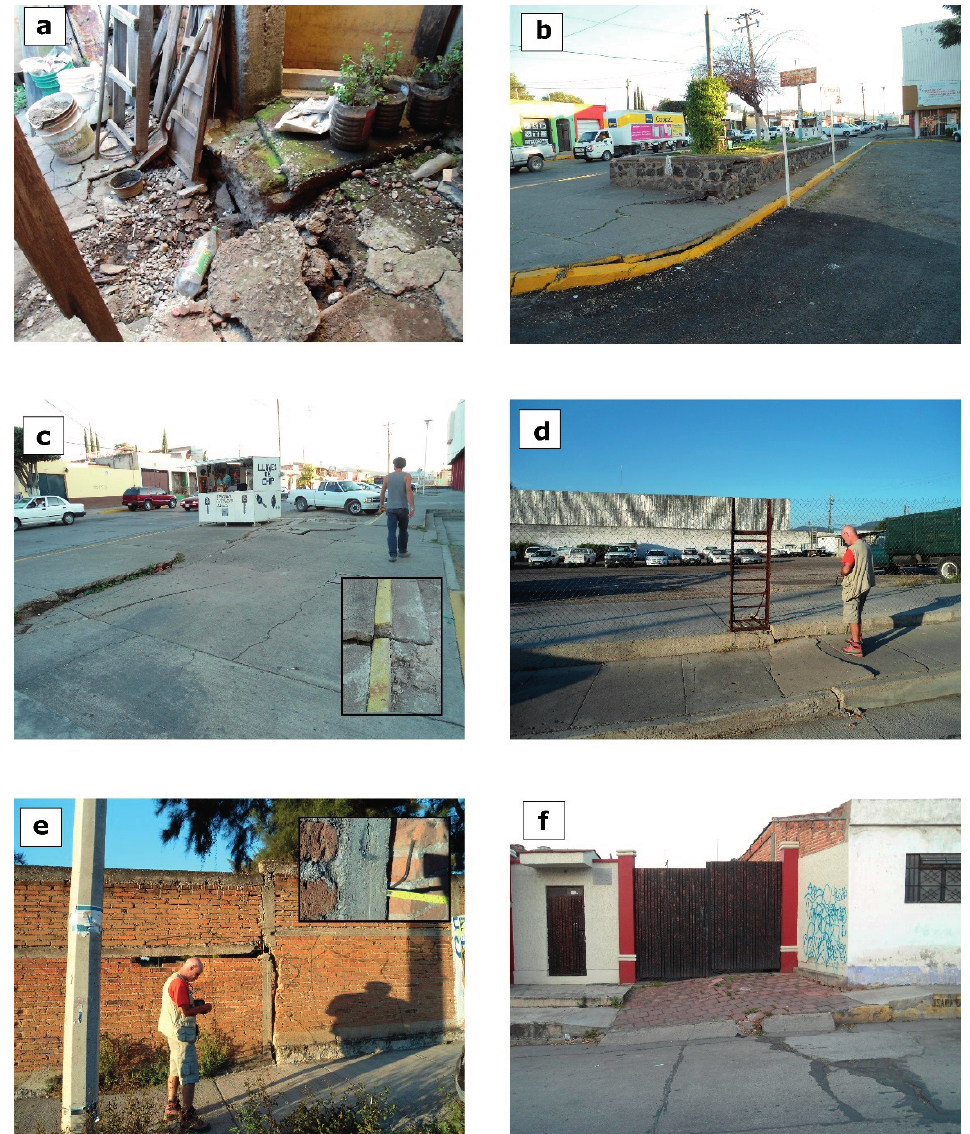
Figure 4. Photos showing evidences of ground fissures and faulting: ( a ) deformed and fractured pavement (site 1); ( b ) crossroads and sidewalk showing the pavement displaced and partially repaired (sites 3 and 4); ( c ) sidewalk affected by normal fault with a minor strike slip offset, as visible in the inset (site 5); ( d ) parking affected by fissures and normal faults (site 6); ( e ) sidewalk and wall affected by normal fault associated with a strike slip offset, as visible in the inset (site 10); and ( f ) street, sidewalk and gate affected by normal displacement (site 11). For the location, see Figure